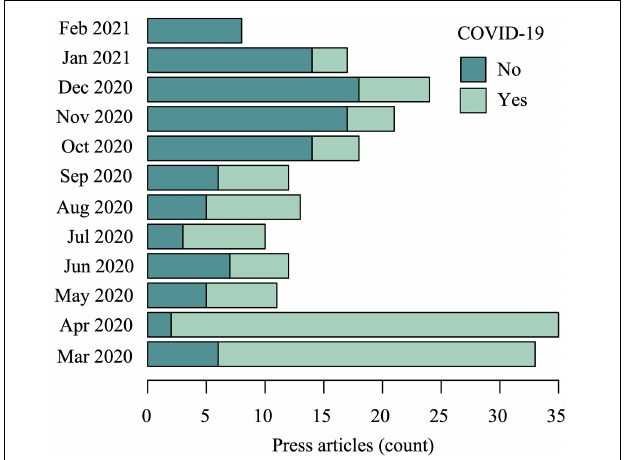
FIGURE 1 | Press news (count) about the Galician fisheries sector published with the keyword covid (light green) and without it (dark green) from March